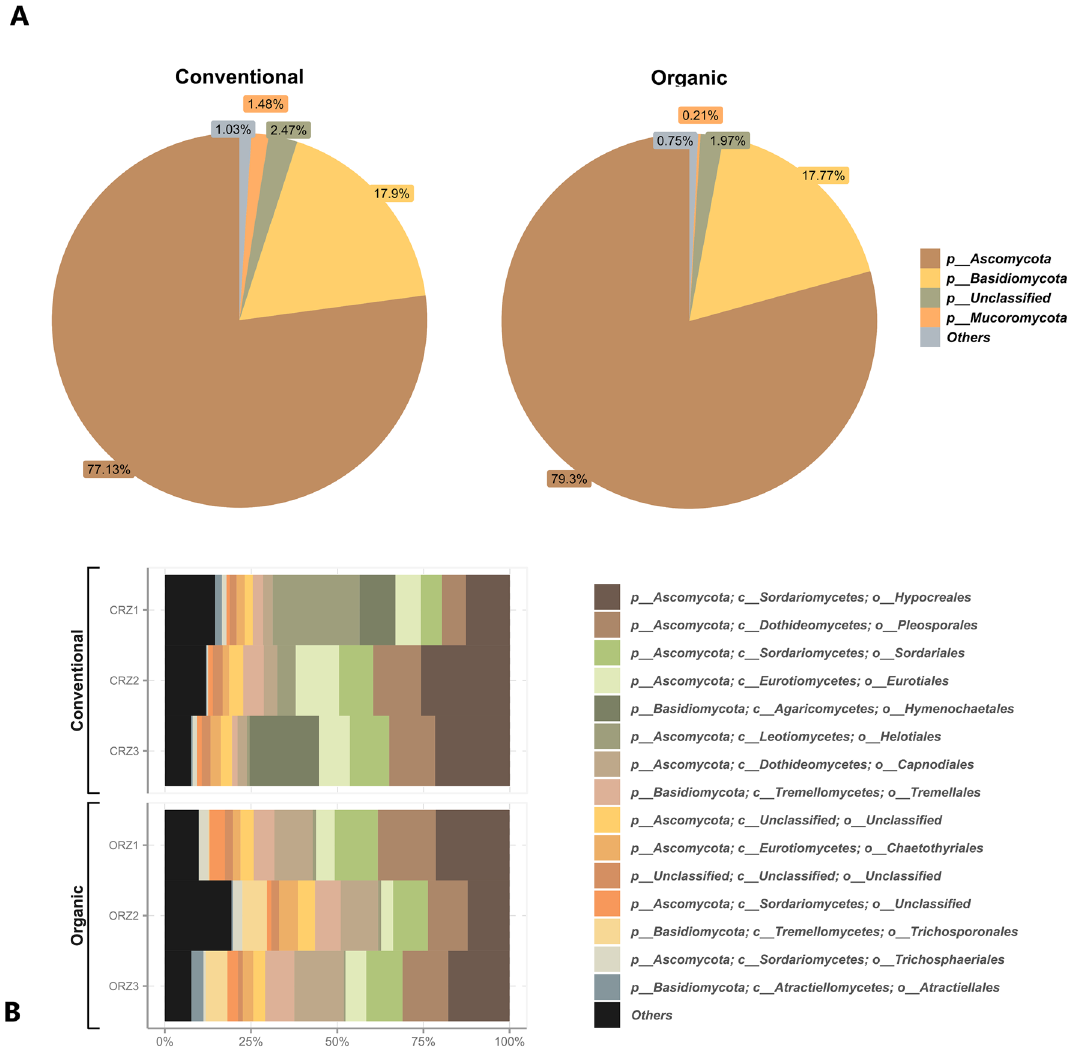
Figure 2. Distribution of the 5 most abundant fungal phyla ( A ) and distribution of the 15 most abundant fungal orders in the sugarcane rhizosphere of the organic (ORZ) and conventional (CRZ) farming systems ( B